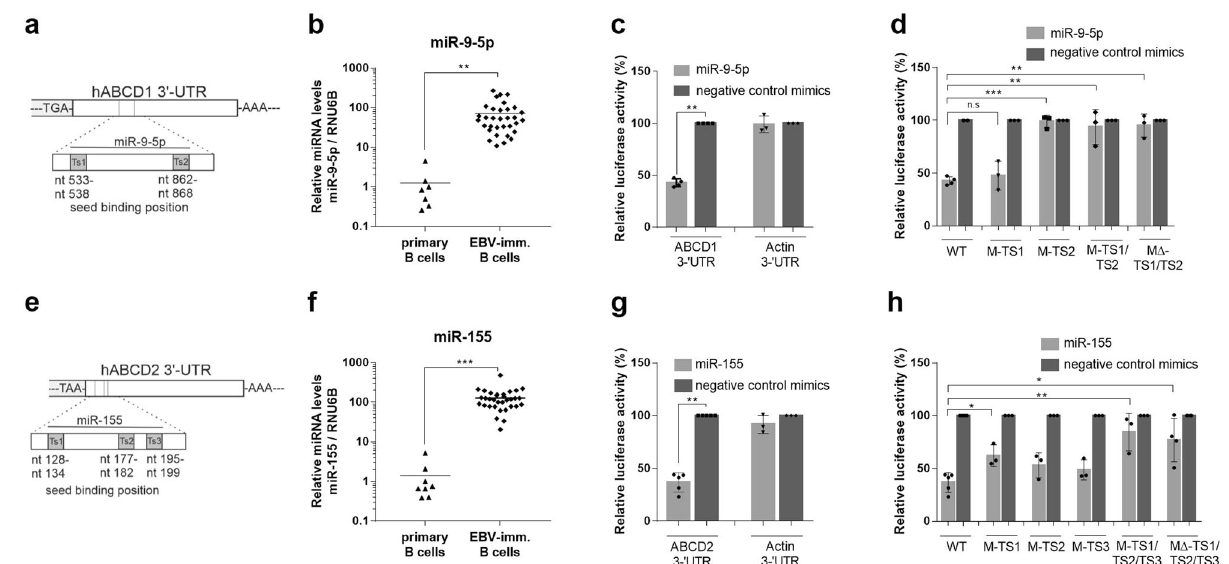
Fig. 3 The peroxisomal VLCFA transporters ABCD1 and ABCD2 are targets of EBV-induced miRNAs. a , e Schematic diagrams of the 3 ′ -UTR of the human ABCD1 (1044 bp) and ABCD2 (1496 bp) cDNAs. The relative locations of the putative miR-9-5p (TS1: nt 533 – 538, TS2: nt 862 – 868) and miR-155 (TS1: nt 128 – 134, TS2: nt 177 – 182, and TS3:195 – 199) target sites are shown as grey boxes. b , f RT-qPCR analysis of miR-9-5p and miR-155 expression in primary B cells ( n = 7 – 8) and EBV-immortalized B lymphocytes ( n = 33). The miRNA levels were normalized to the small non-coding RNA, RNU6B, as unregulated reference. The mean is indicated by a horizontal line. c , d , g , h Luciferase reporter assays in HEK-293 cells harbouring ABCD1- ( c ) or ABCD2- ( g ) 3 ′ -UTR constructs and a β -actin-3 ′ -UTR (negative control) construct co-transfected with either miR-9-5p, miR-155 or non-targeting negative control mimics as indicated. The data is displayed as percentage of Renilla/Fire fl y luciferase activity ratio (mean ± S.D.) relative to that of cells transfected with negative control mimics. Each data point represents an independent transfection experiment. In the mutated ABCD1-3 ′ -UTR constructs M-TS1, MT-S2, M- TS1/TS2, and M Δ -TS1/TS2 ( d ) or ABCD2-3 ′ -UTR constructs M-TS1, M-TS2, M-TS3, M-TS1/TS2/TS3 and M Δ -TS1/TS2/TS3 ( h ), the putative miR-9-5p or miR-155 binding sites were either in vitro mutagenized (M) or deleted (M Δ ). * p ≤ 0.05, ** p ≤ 0.01, *** p ≤ 0.001 (two-tailed unpaired Student ’ s t -test, correction for multiple testing by Bonferroni